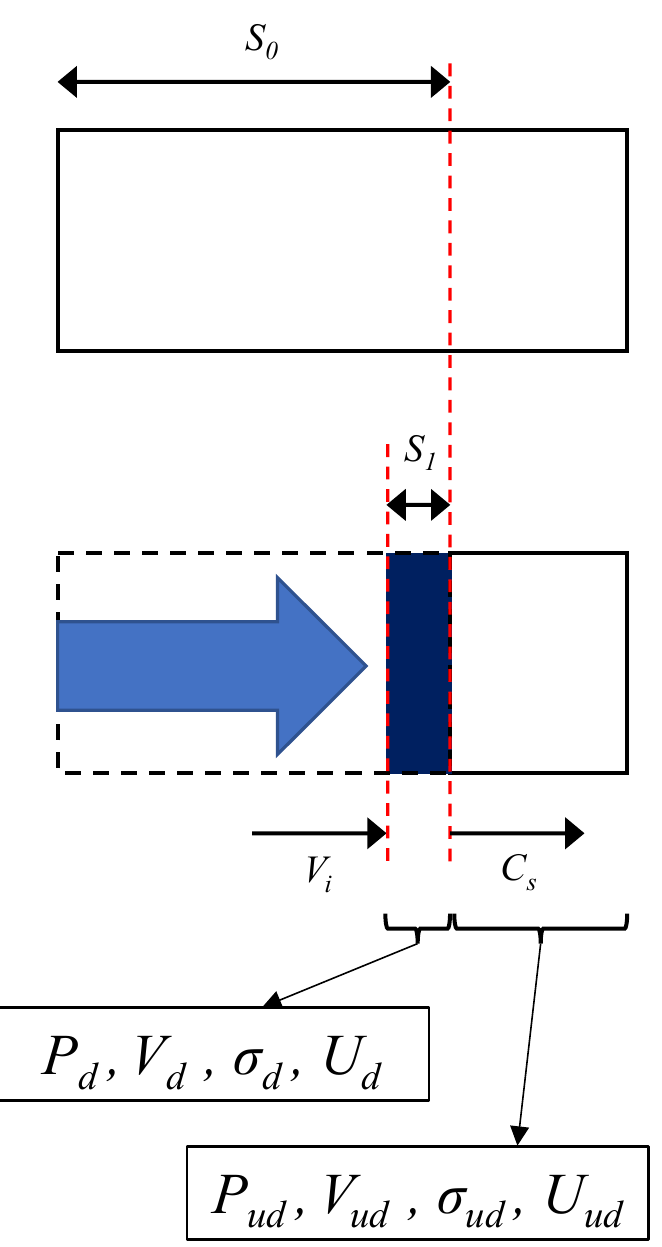
Figure 16. Physical quantity inside material during nonuniform deformation. Figure 17 shows the simple stress–strain relationship of a typical cell structure. The elastic modulus of cell structure E e is the slope of the elastic response, and strain-hardening exponent E p is the slope of the plateau region. In other words, when the bulk density of the specimen is ρ cell , plastic stress wave speed C p is expressed as: